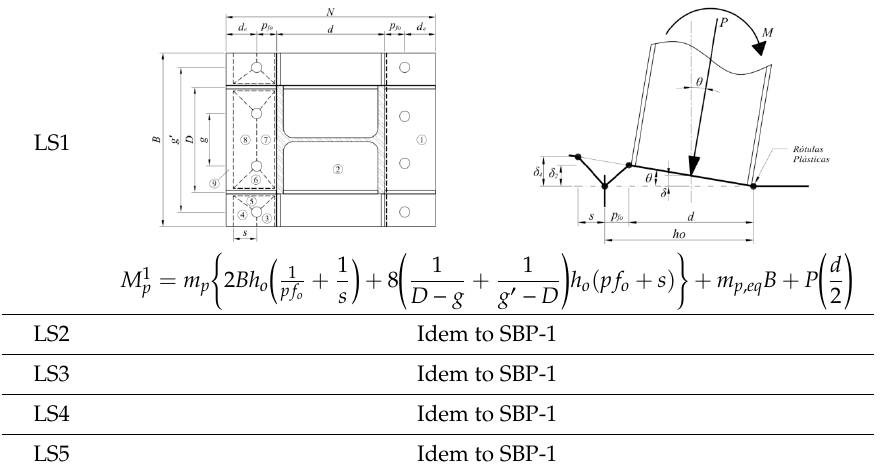
Table 6. Limit states that control the design of base plate type SBP-3.